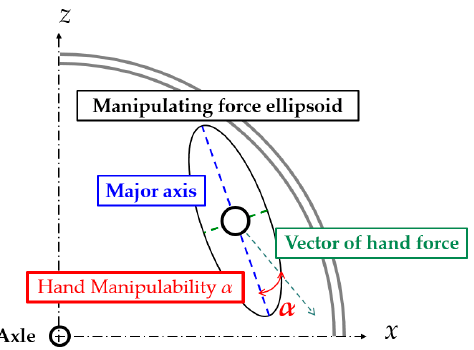
Figure 3. This figure defines hand manipulability. Hand manipulability was defined as the angle between major axis of manipulating force ellipsoid and the vector of the hand force. The hand force was represented by the force generated at the center of the hand in the musculoskeletal model. The direction of the hand force was shown as the resultant force of the x and z axes components at the rotating surface.